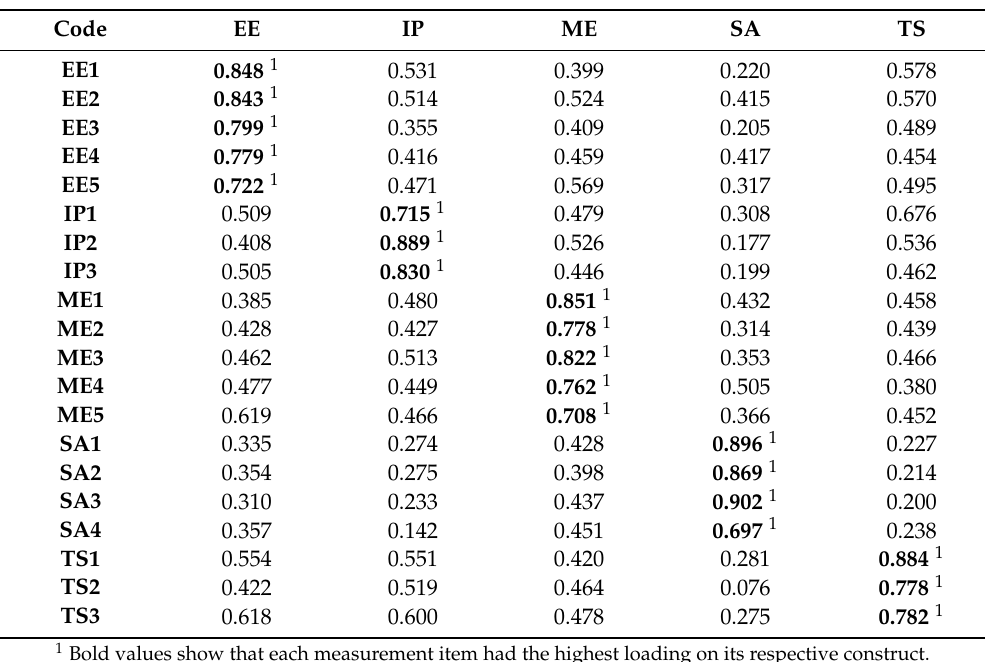
Table 8. Cross loadings of the hypothesized model.